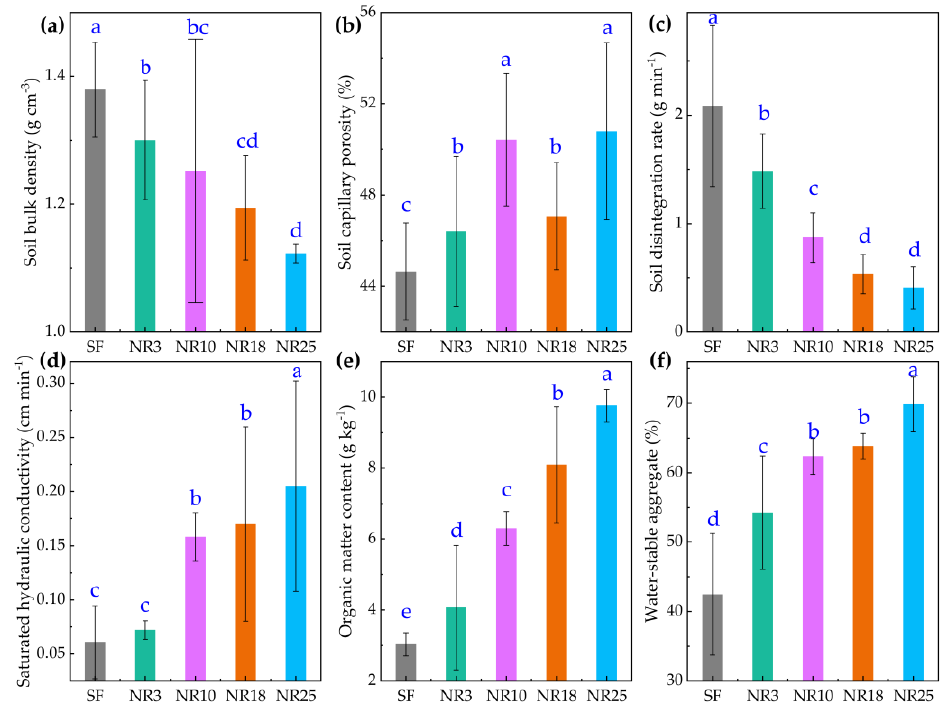
Figure 3. Variation in soil properties with revegetation age. Note: Bar means the 95% confidence interval (95% CI). Different lowercase letters indicate significant difference among different revegetation ages ( p < 0.05). ( a ) Soil bulk density (SBD); ( b ) Soil capillary porosity (SCP); ( c ) Soil disintegration rate (SDR); ( d ) Saturated soil hydraulic conductivity (SHC); ( e ) Organic matter content (OMC); ( f ) Water-stable aggregate (WSA).